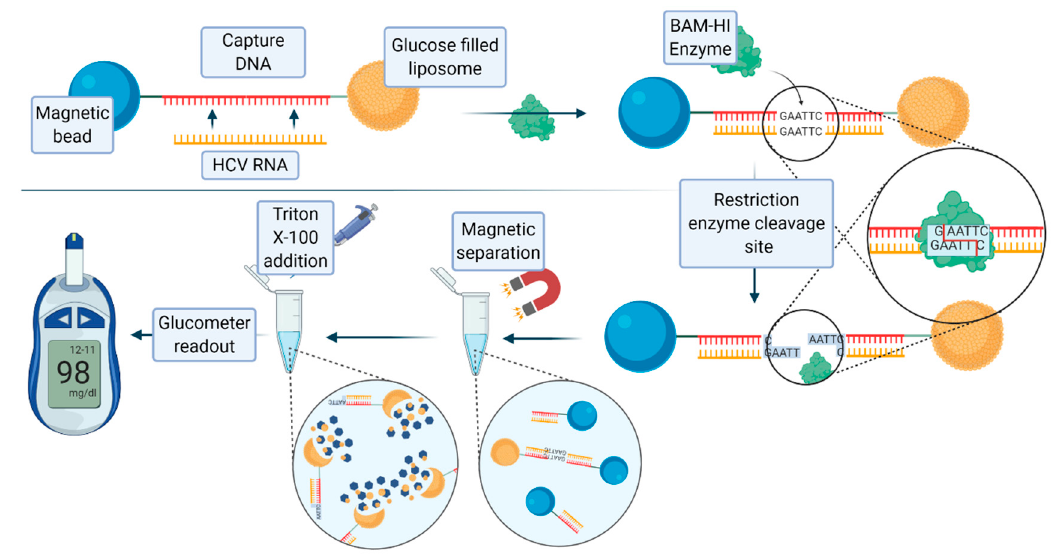
Figure 7. Detection of hepatitis C virus (HCV) RNA through the interaction of glucose-loaded liposomes with probe carrying magnetic beads. Upon the action of the restriction enzyme BamHI, the release of the glucose-containing liposomes occurs. Next, the release of glucose from the liposomes takes place by the addition of Triton-X-100 and is determined through a glucometer. Figure inspired by [60].